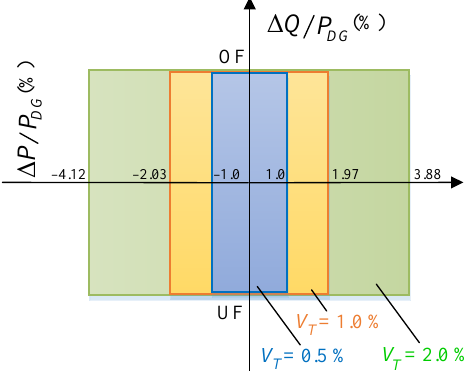
Figure 4. Voltage threshold selection in the term of non-detection zone.